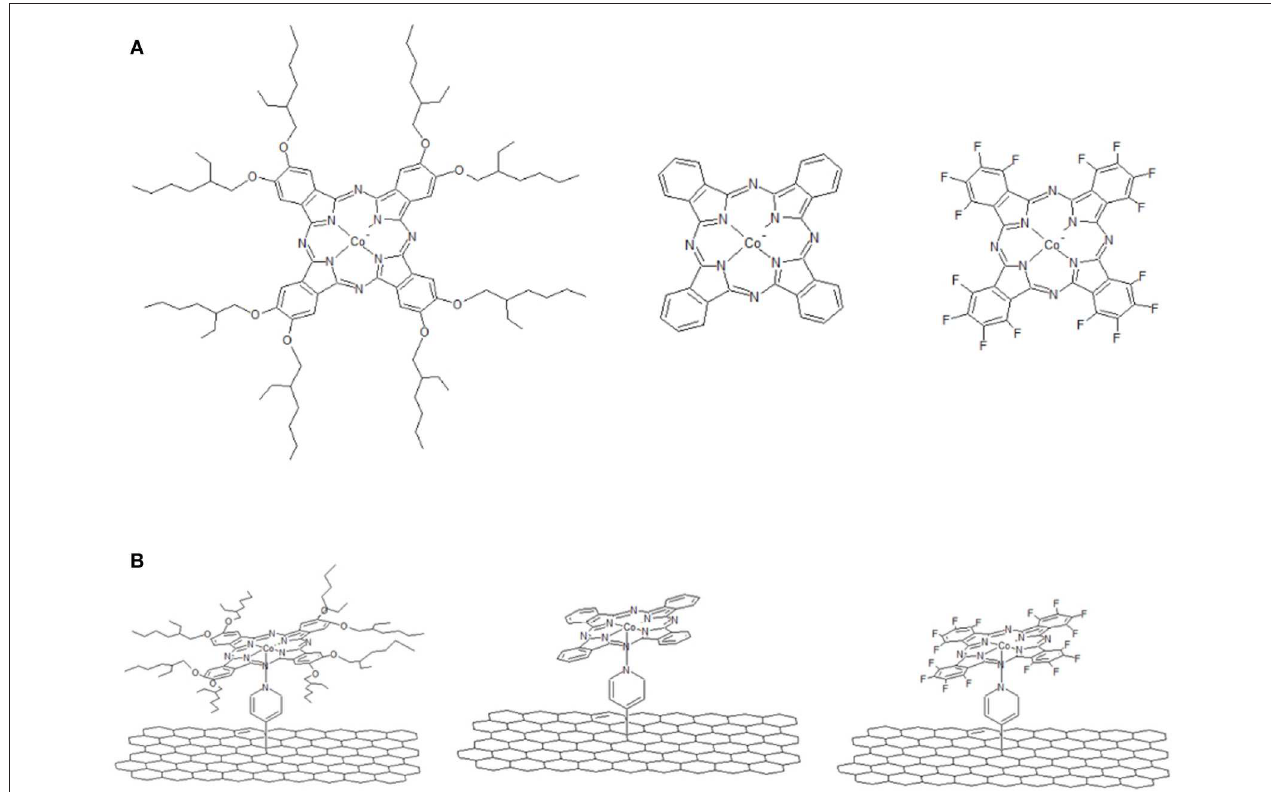
FIGURE 1 | (A) Schematic representation of CoN4. From left to the right: 8(2-Et-C 6 H 11 O)CoPc, CoPc, and 16(F)CoPc. (B) Schematic representation of CoN5. From left to the right: 8(2-Et-C 6 H 11 O)CoPc-Py-CNT, CoPc-Py-CNT, and